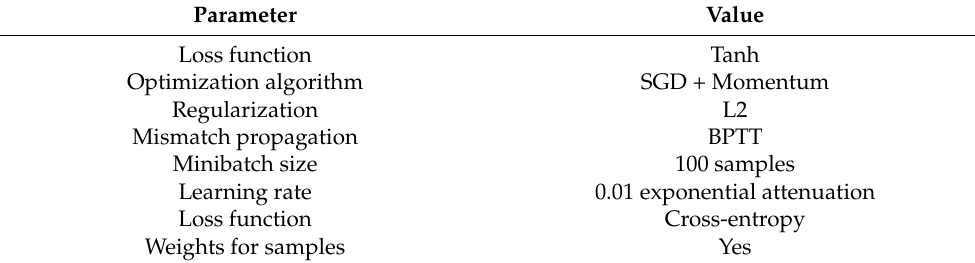
Table 2. Parameters of the